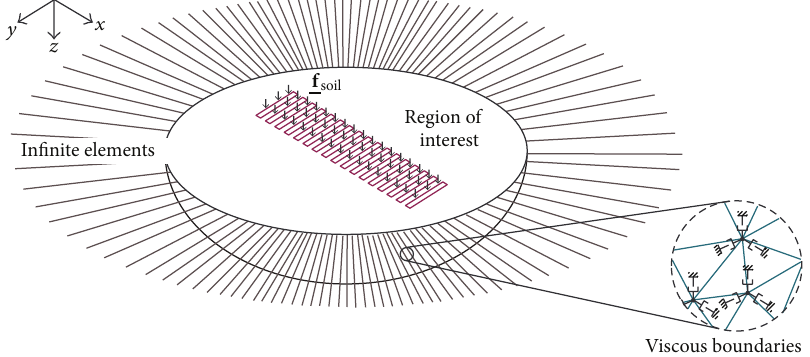
Figure 3: The finite/infinite element model for the